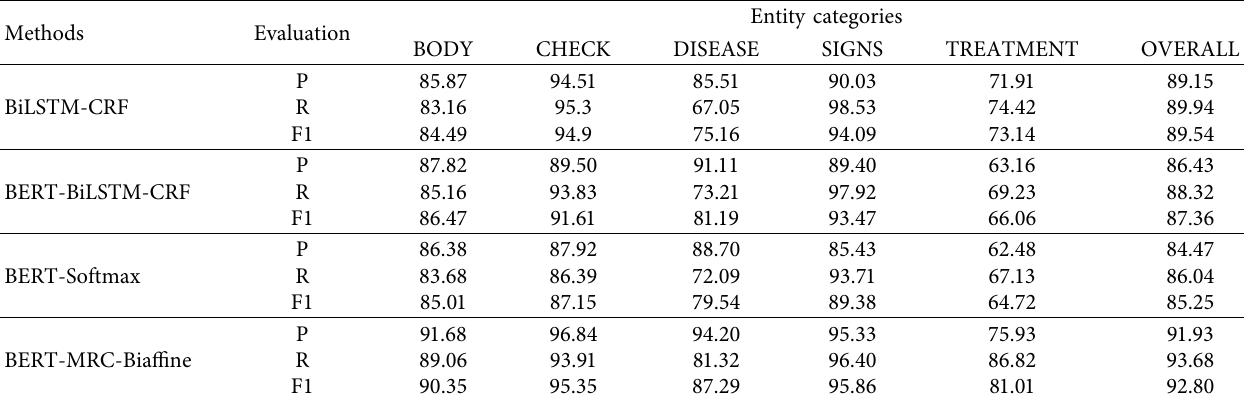
Table 4: The result for the entity recognition task (Precision, Recall, and F1).